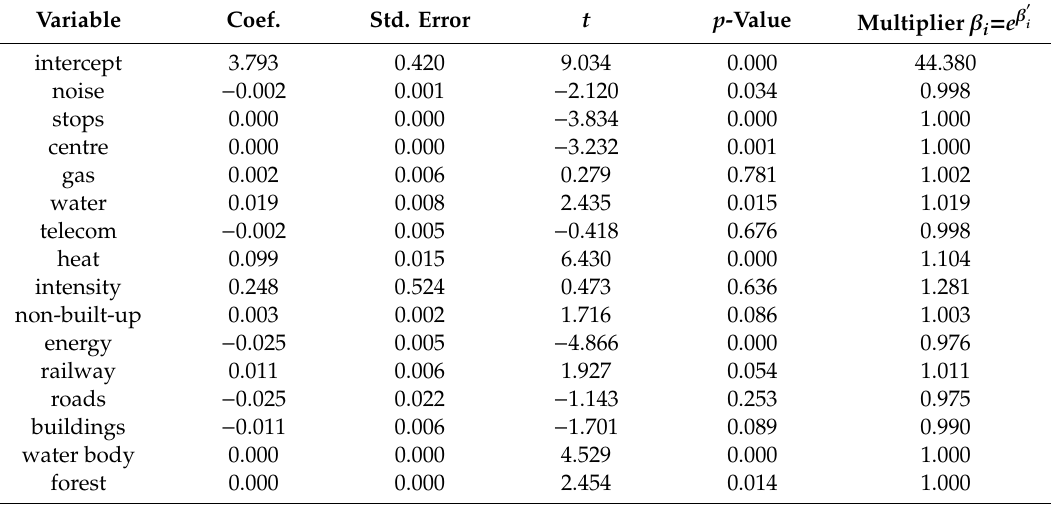
Table 6. Basic statistics of the spatial lag model.